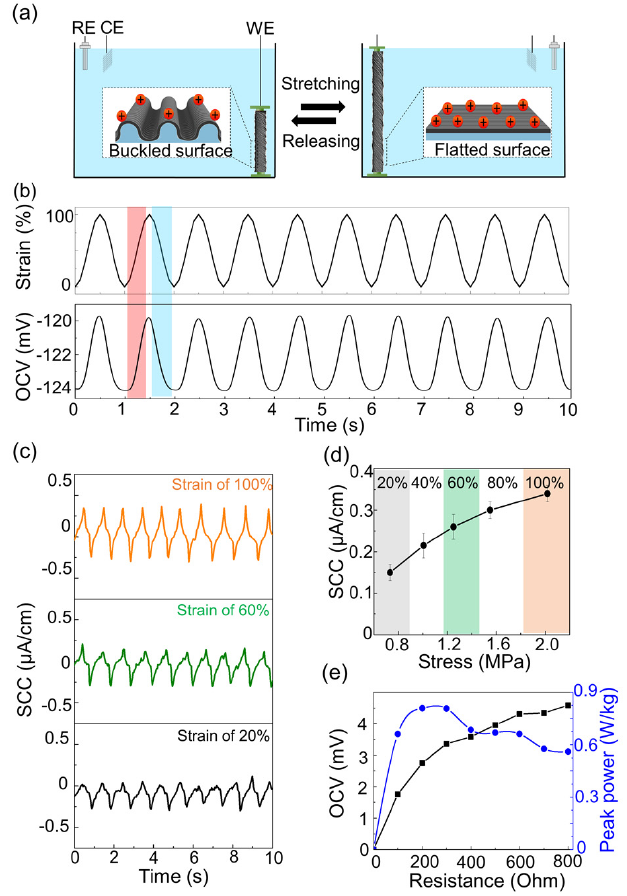
Figure 2. Generation of electricity by mechano-electrochemical harvesting fiber for self-powered strain sensor: ( a ) schematic of electricity generation by buckled fiber with mechanical stretching in electrolyte; ( b ) sinusoidally applied tensile strain results in an open-circuit voltage; red and blue areas denote stretched and released states, respectively; ( c ) short-circuit current at different applied strains, from 20% to 100% during 1 Hz sinusoidal stretch in saline; ( d ) SCC output with applied stress; ( e ) peak-to-peak voltage and peak power of MEH with external load resistance.